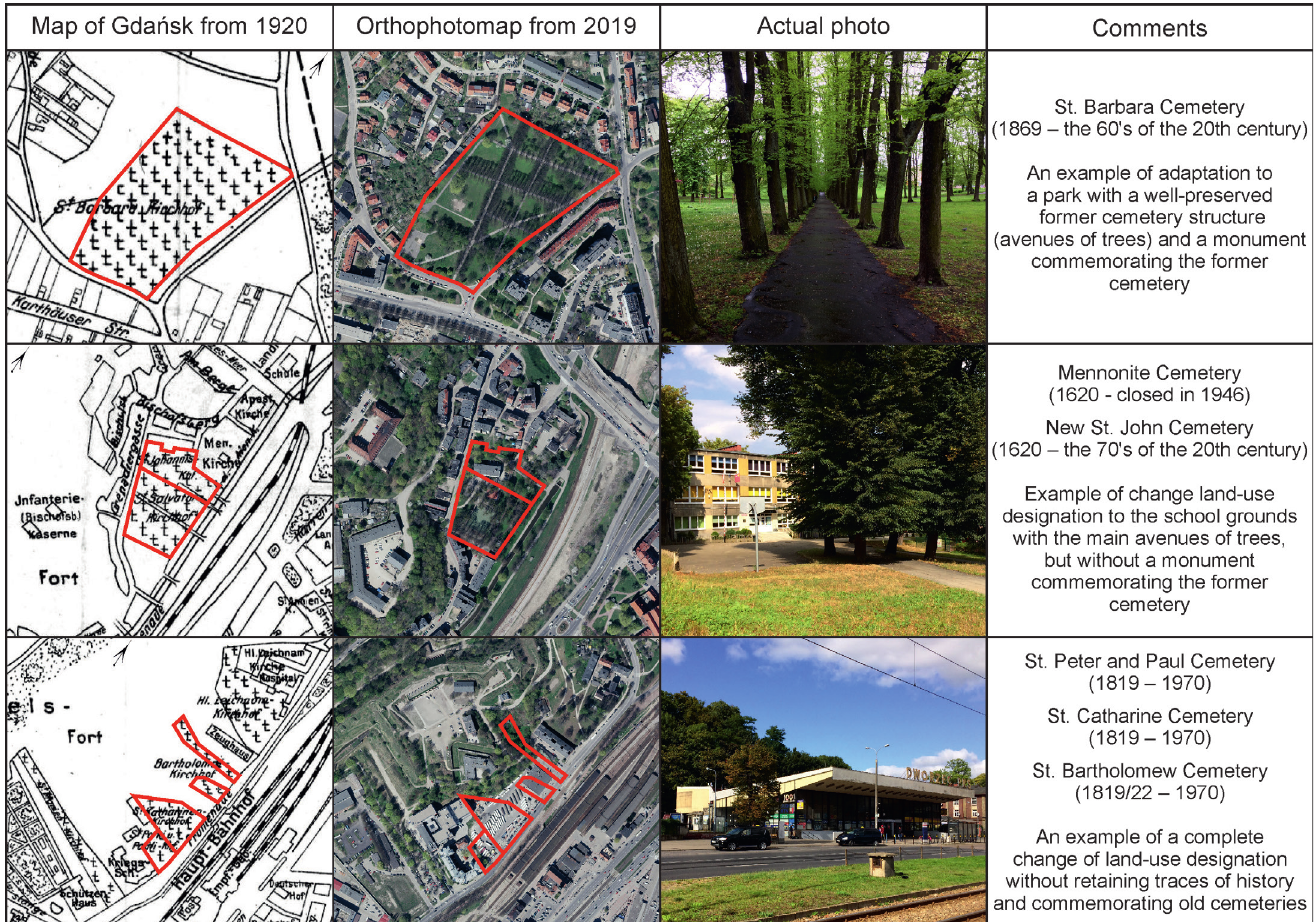
Figure 13. Examples of change of land-use designations after former cemeteries. Source: Archiwalne Mapy Pomorza Gdańskiego (2019), Geoportal (2020). Photo: K.